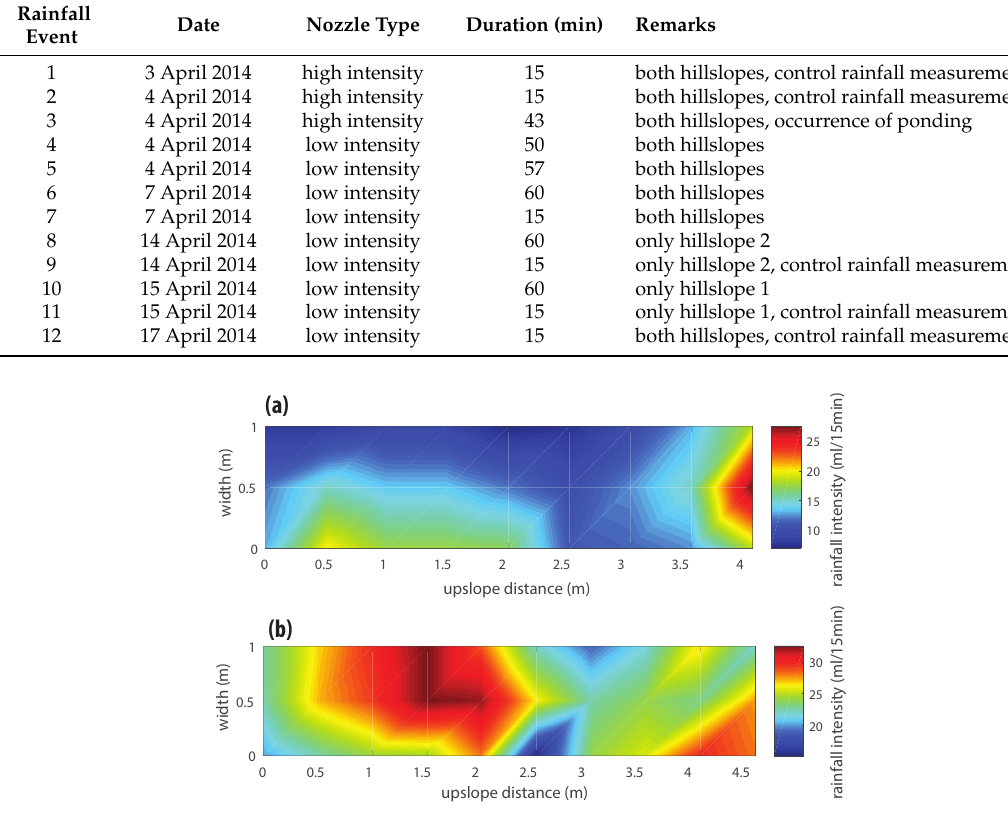
Figure 5. Comparison of the spatial distribution of rainfall intensities for two different nozzle types. ( a ) low intensity nozzles; and ( b ) high intensity